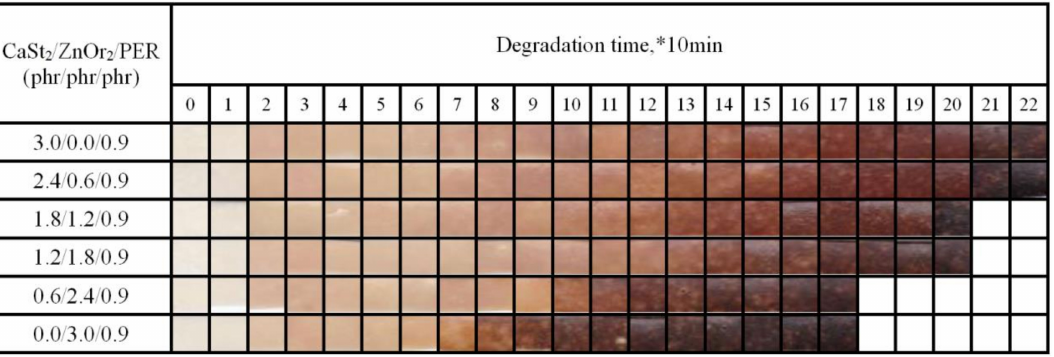
Figure 14. The effects of thermal stability time for PVC with different proportions of CaSt 2 /ZnOr 2 /PER thermal stabilizers at 180 ◦ C.